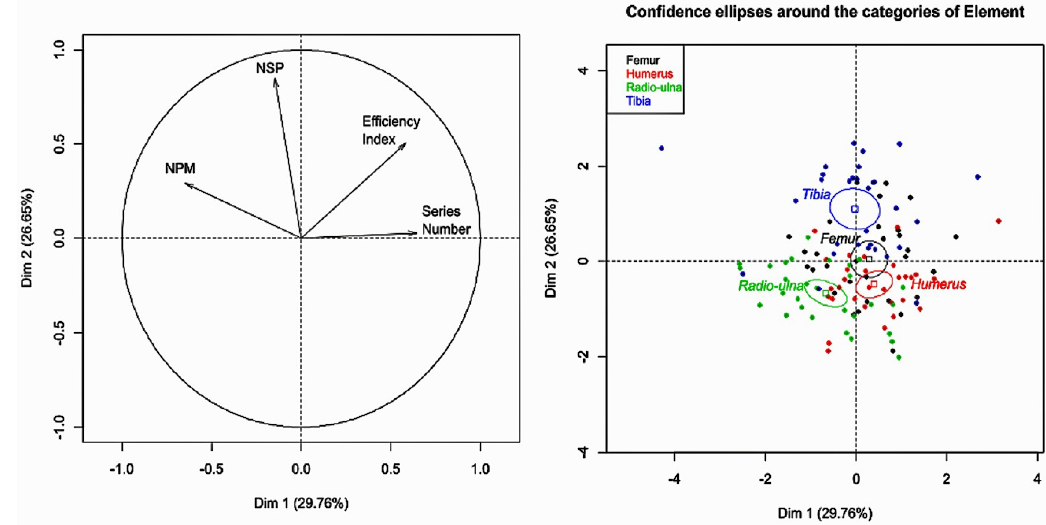
Fig 3. PCA analyses of variable tested. PCA regarding the number of identified remains (NISP), the number of percussion marks (NPM), the Efficiency Index and the number of attempts (Series Number) with ellipses at 0.95. https://doi.org/10.1371/journal.pone.0259136.g003 Percussion mark types and spatial distribution. We observed around 5,000 percussion marks on the identified fragments Table 6. Pits were the most numerous (78%) and grooves were the least frequent marks (2.6%). Both triangular and ovoid pits were present, but the for- mer were less numerous. We recorded more pits on the tibias and radio-ulnas than on the other bone types. Adhering flakes and notches represented 15% of all the percussion marks.